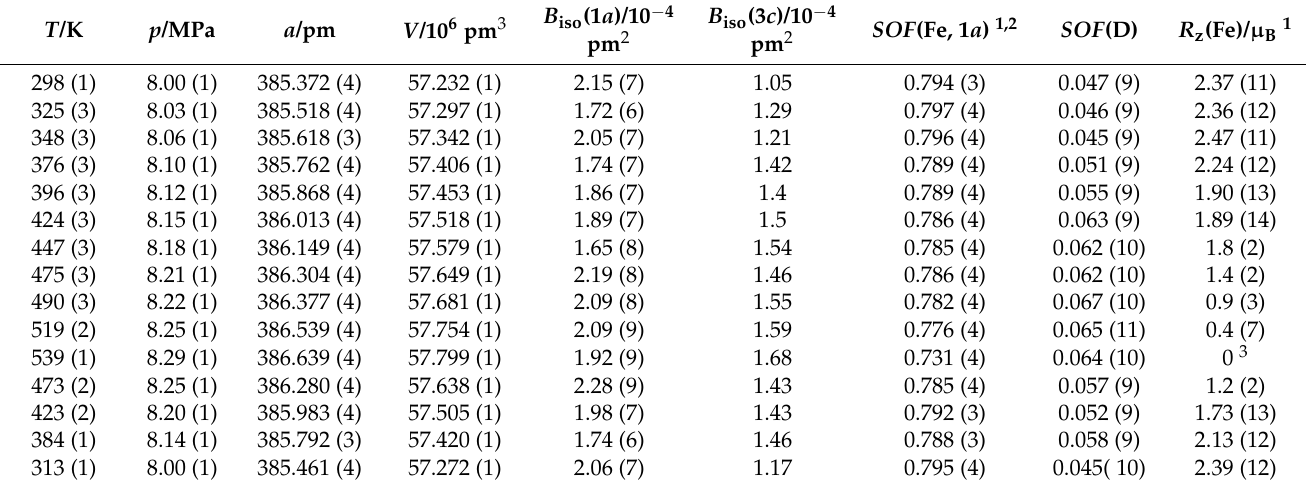
Figure A13. Rietveld refinement of the crystal structure of FePd 3 D 0.047(9) (for details, see sixth row in Tables A6 and A7, or first row in Tables A8 and A9) based on neutron powder diffraction data (NUMOR 131746 [21], λ = 186.80(2) pm, D20 ILL, Grenoble) in a single-crystal sapphire cell at 296(1) K and 8.00(1) MPa deuterium pressure using FullProf [24]. Table A8. Conditions and refined parameters of the Rietveld refinement of FePd 3 ( Pm 3 m ) based on in situ NPD data (see Figures 2–4 and Table A9) using FullProf [24].